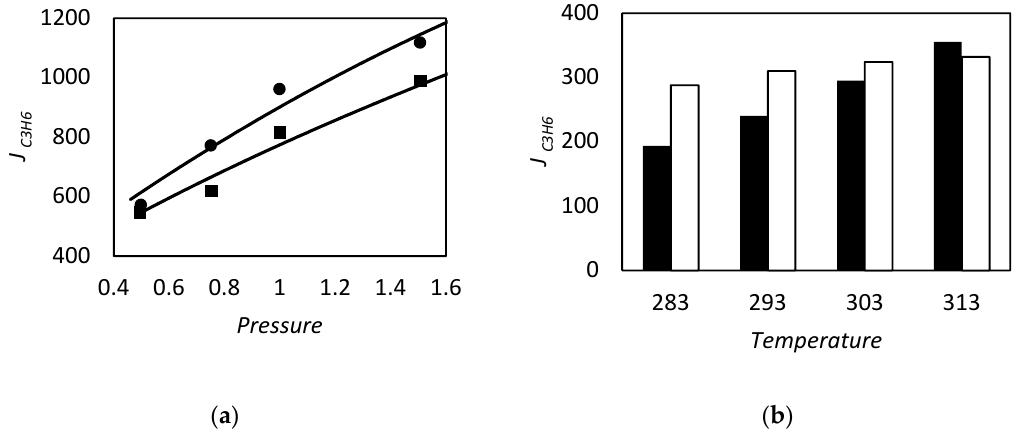
Figure 18. Ethylene flux in polymeric membranes (PVDF-HFP)/BMImBF 4 /AgBF 4 . ( a ) Influence of ethylene pressure at two different temperature. Symbols are experimental data, lines are model calculations from Zarca et al. [18]. From the top, T = 303.15 K, 293.15 K; ( b ) Prediction of fixed site (black) and mobile carrier (white) contribution to total flux as function of temperature. Flux is expressed in (1 × 10 − 6 mol/cm 2 · s), pressure is in (atm), temperature is in (K).